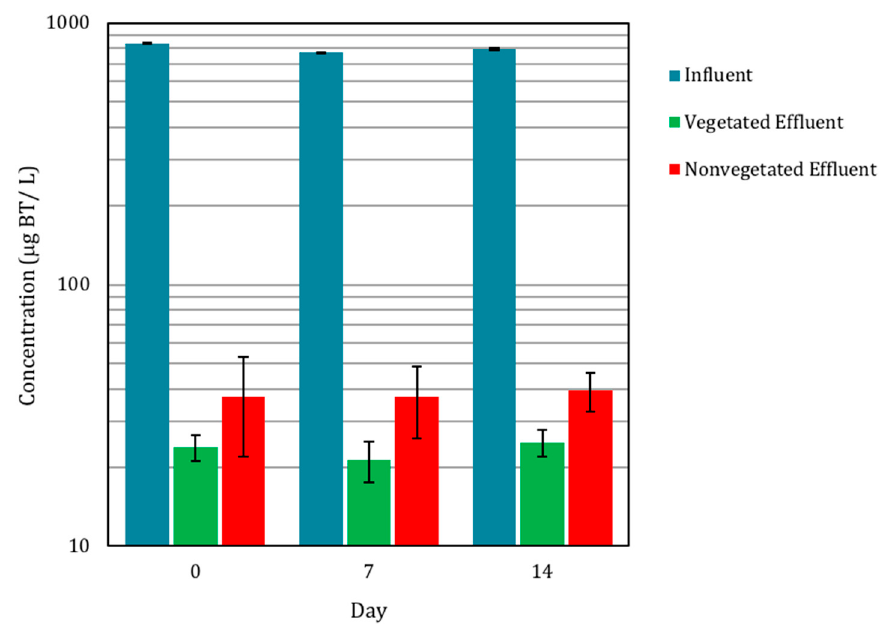
Figure 3. Log plot of BT concentrations in storm water influent (blue) and effluent during the three storm events for the vegetated (green) and nonvegetated (red) biofilters. Error bars represent one standard deviation ( n = 6). The difference between vegetated and nonvegetated effluent is statistically significant ( p < 0.01, repeated measures ANOVA with Tukey HSD).